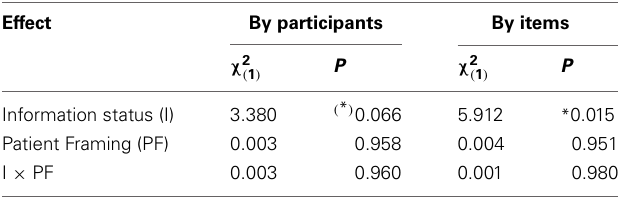
Table 9 | Generalized-Score Chi-Squares from binary logistic GEE analyses, predicting the likelihood of get-passive responses by factor combinations of Information Status (given Agent or given Patient) and Patient Framing (Agent-like or Patient-like).